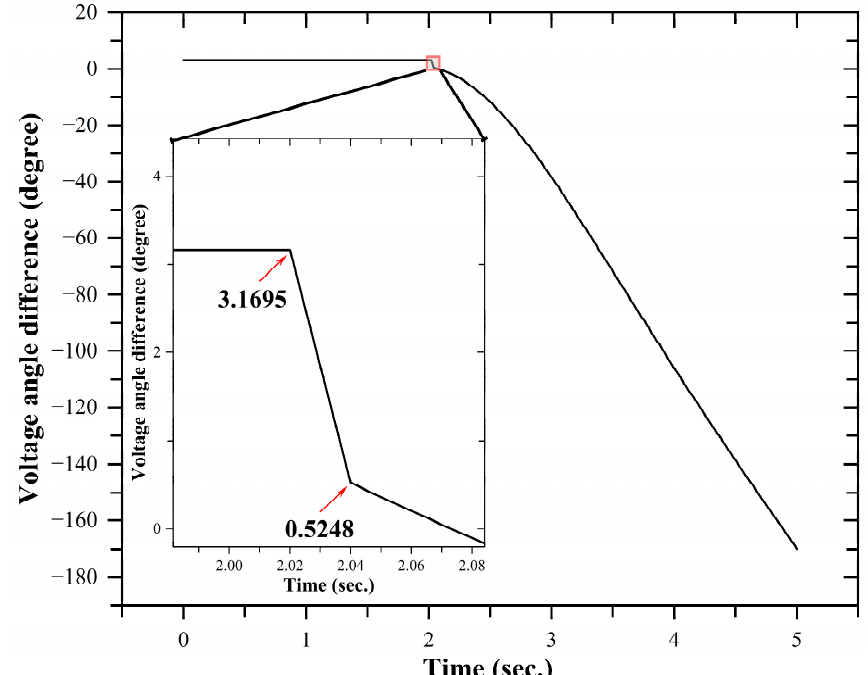
Figure 10. Proposed unintentional island threshold technique for under frequency Scenario 2.